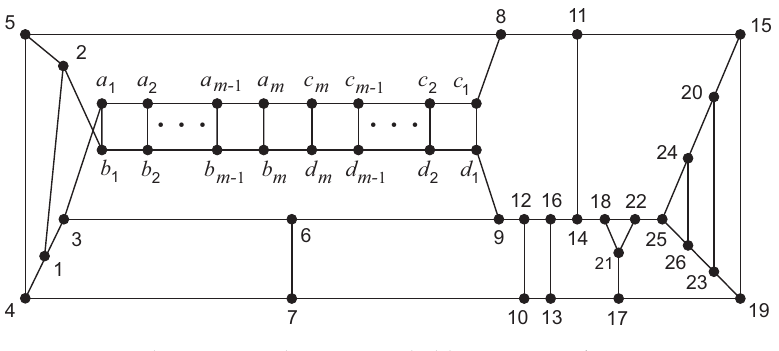
Figure 4. Graph G 16 + 10 k with a growing ladder, m = 8 + 5 k